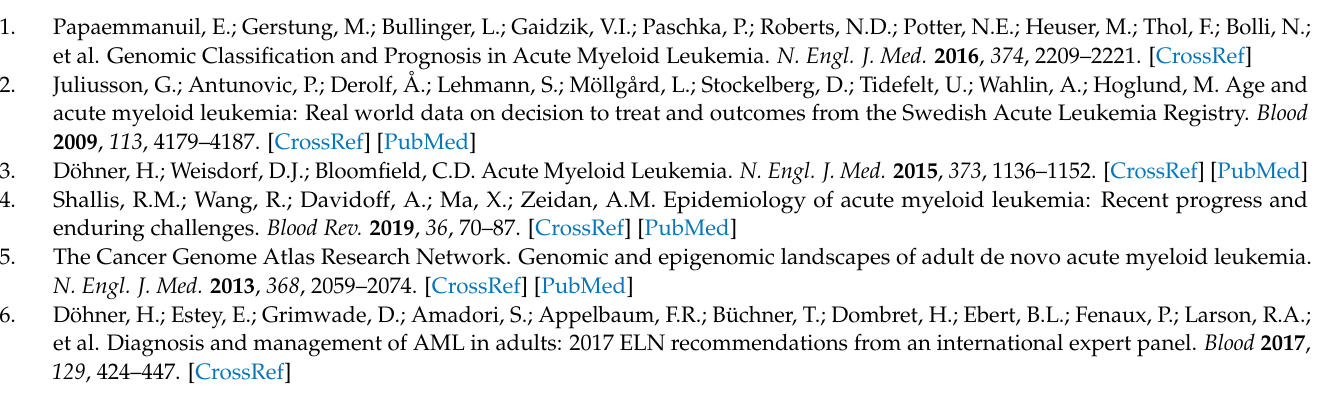
Figure S5. Clinical and genetic correlation with TRH expression in the Beat AML datasets. Statistical significance was determined using the Wilcoxon test; Figure S6. Correlation of TRH expression with the proportion of immune cells in TCGA AML datasets. Spearman’s correlation analysis and correlation coefficient ( R ) are